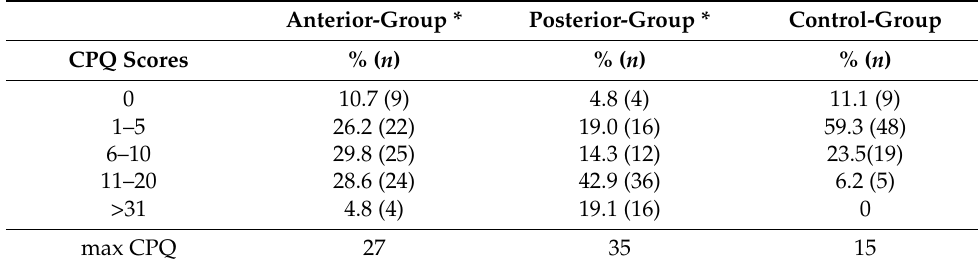
Table 4. Range of the Total-CPQ-Scores. Anterior-Group * Posterior-Group * Control-Group CPQ Scores % ( n